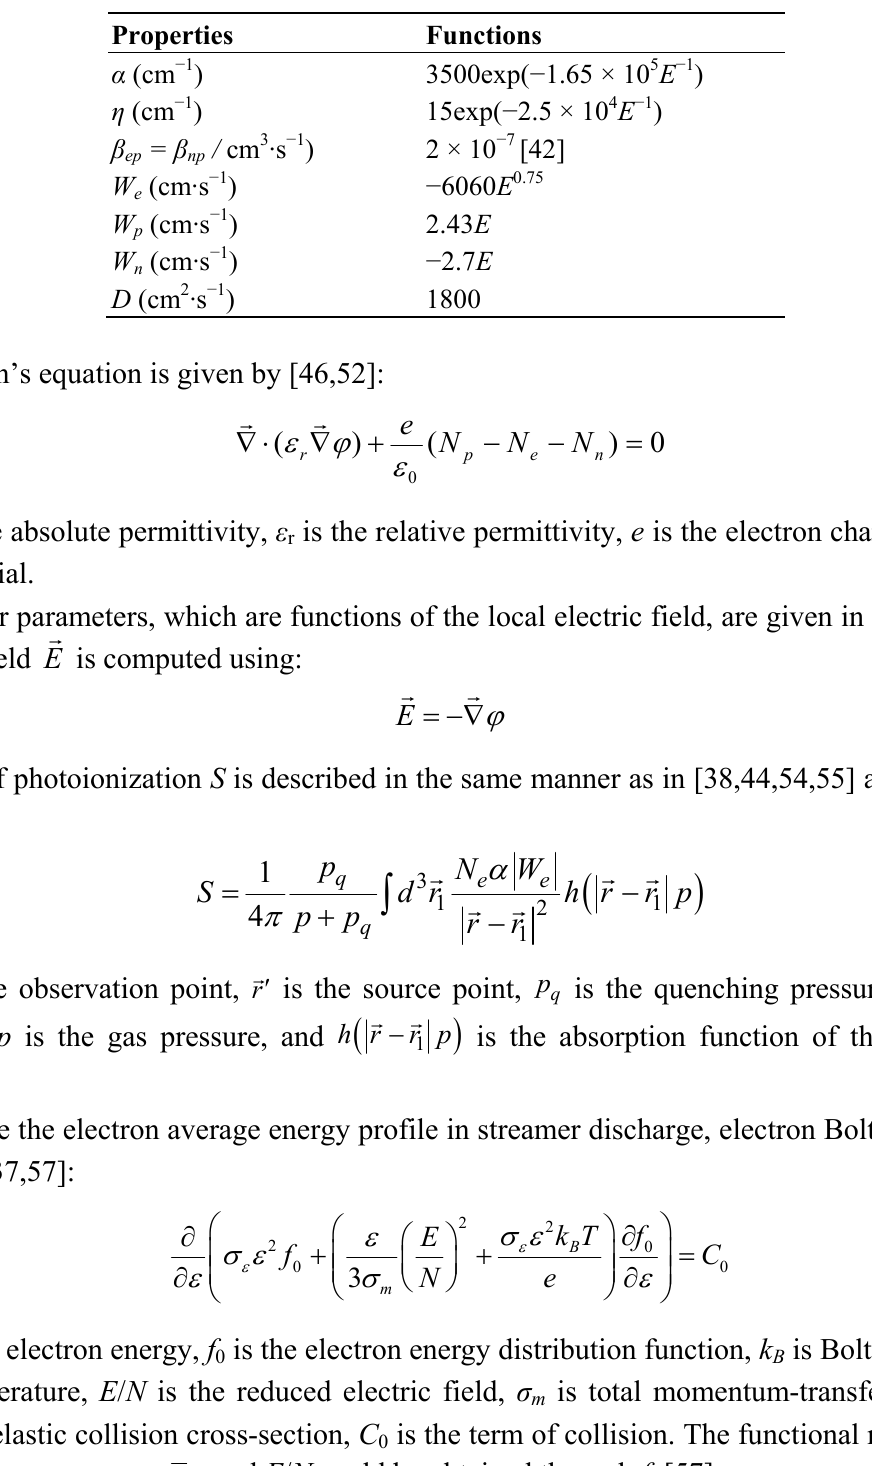
Table 2. Transport properties of air given by Morrow and Lowke [42] and Kang et al. [17] ( E in volts per